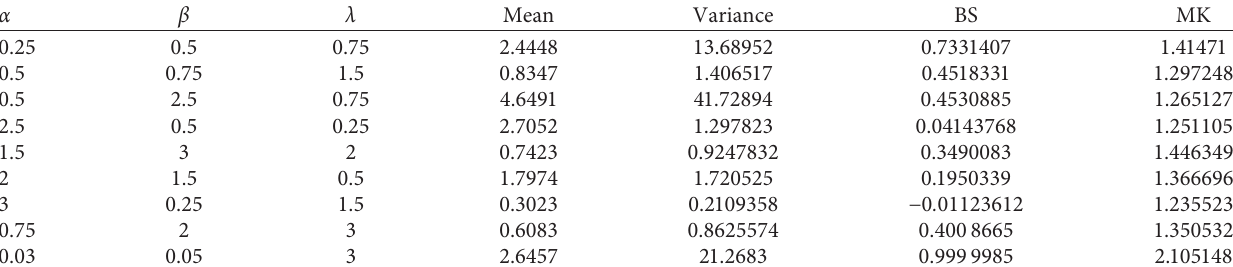
Table 1: Numerical values of mean, variance, BS, and MK of DEOWE